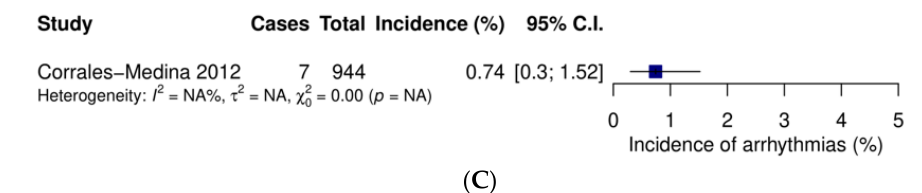
Figure 5. Forest plots of incident arrhythmias after community-acquired pneumonia. ( A ) Inpatients ( B ) High-risk inpatients ( C ) Outpatients. CI: confidence interval.